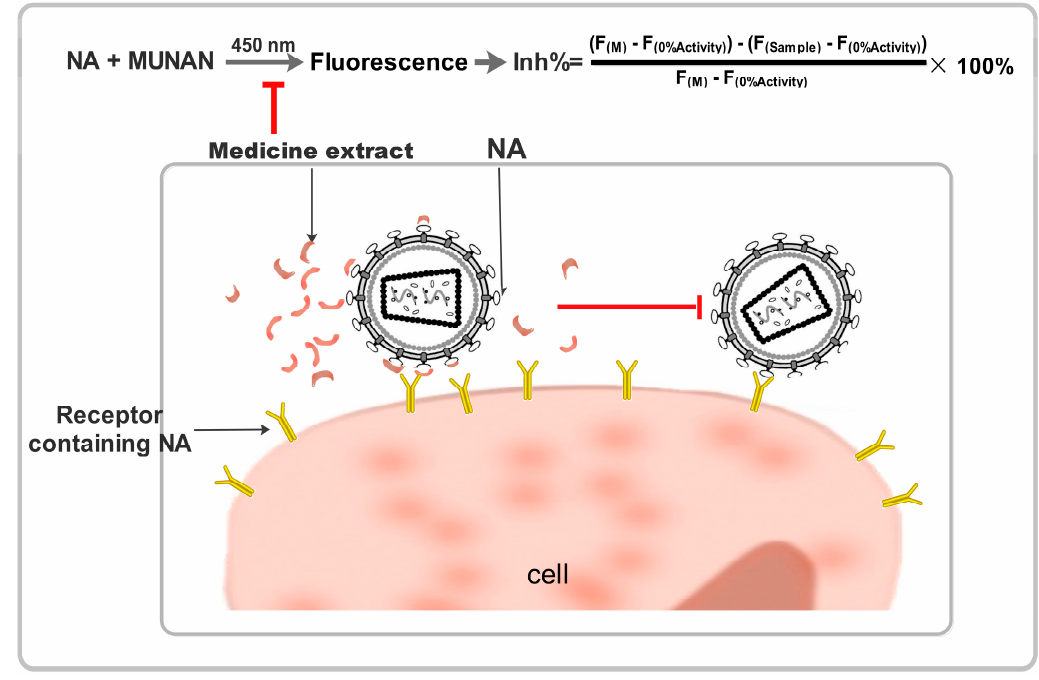
Figure 2. Schematic diagrams showing the neuraminidase inhibiting effect of Chinese medicine.